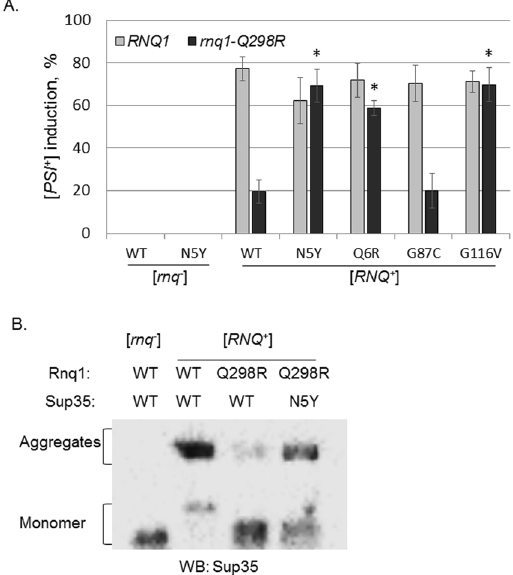
Figure 5. Sup35-N5Y strongly rescues the [ PSI + ] induction defect. ( A ) [ PSI + ] induction experiments demonstrate that three Sup35 mutants restore [ PSI + ] formation to nearly WT levels in rnq1-Q298R cells. These mutations do not increase [ PSI + ] formation in a RNQ1 genetic background. Horizontal axis labels denote SUP35 genetic status. The [ rnq − ] control cells express RNQ1 and SUP35 . More than 13,000 colonies were assessed over five biological replicates. Error bars represent mean ± s.e.m. The “ * ” symbols represent a significant difference between [ PSI + ] induction with WT Sup35 in rnq1-Q298R versus induction with the indicated sup35 mutants, p < 0.005. ( B ) Boiled gel assays allow separate migration of monomeric and aggregated materials, confirming that Sup35 aggregation is reduced in the SUP35 rnq1-Q298R background relative to SUP35 RNQ1 cells. Sup35 aggregation is restored in sup35-N5Y rnq1-Q298R cells. We attribute the slightly aberrant monomer bands as an artifact of the experimental procedure, as samples were unboiled (and likely non-denatured) as per the protocol, and Sup35 may shed unevenly from aggregates in addition to the soluble pool. Western blot is a representative image from three independent